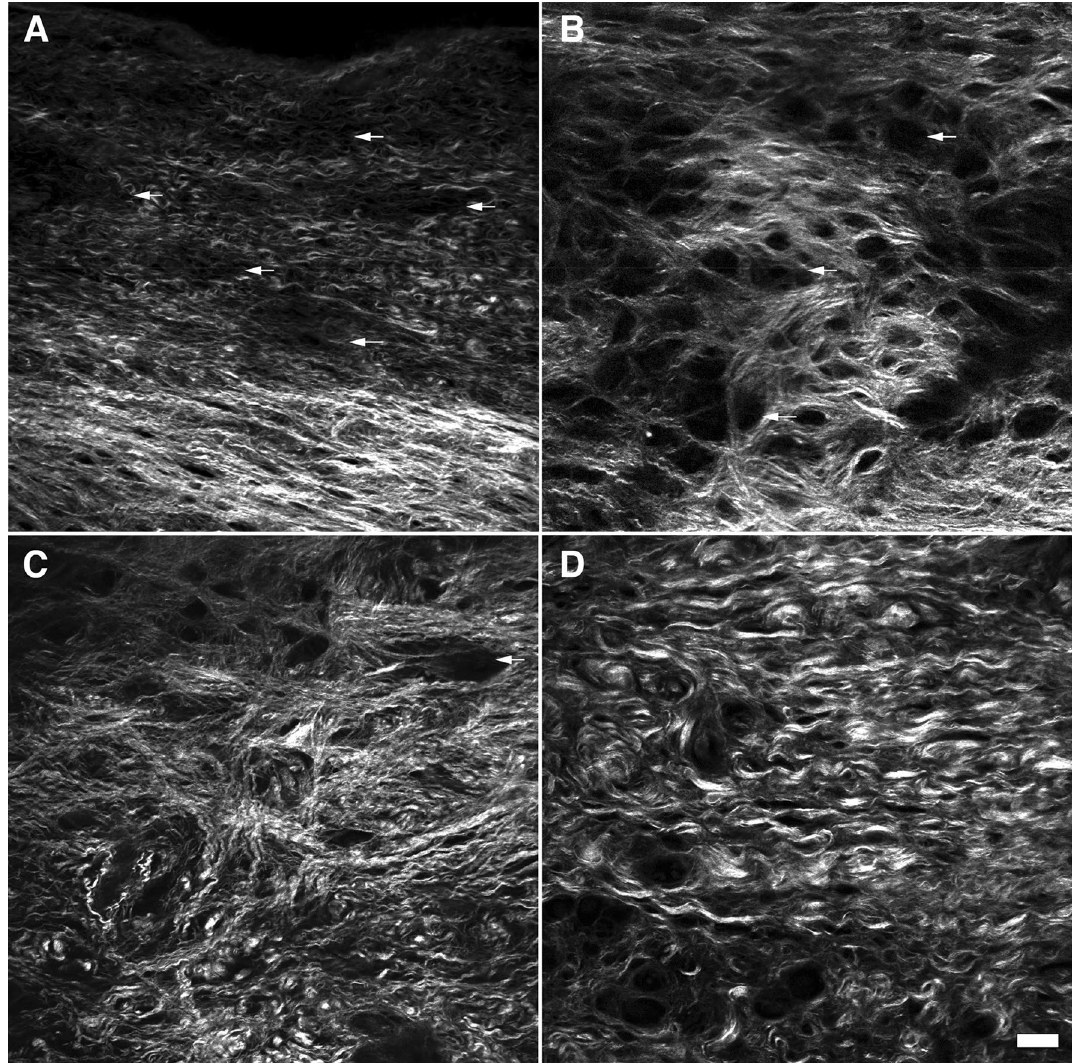
Figure 6. Shape and arrangement of collagen fibers in the mid-membranous adult vocal fold observed under SHG. A 50-year-old female vocal fold lamina propria shows loose collagen fiber under the SLP (A) with distant fenestrations (arrows). The mid-region is arranged in an intertwined framework with frequent and large fenestration ( B ). Transition zones allow secure the vocal ligament (C) . Deep within the LP collagen fibers are densely packed and run parallel to the vocal fold edge (D) . Scalebar: 50